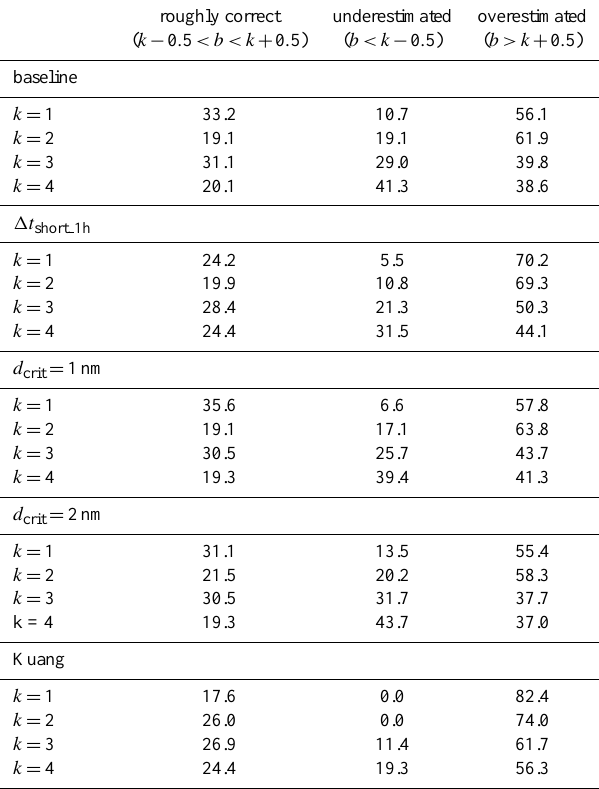
Table 4. Accuracy of best fit exponent b calculations when corre- lating J 1 . 5 ∼ [H 2 SO 4 ] b . The accuracy is given as percentage (%) of analysed events in the same three classes as in Table 3. roughly